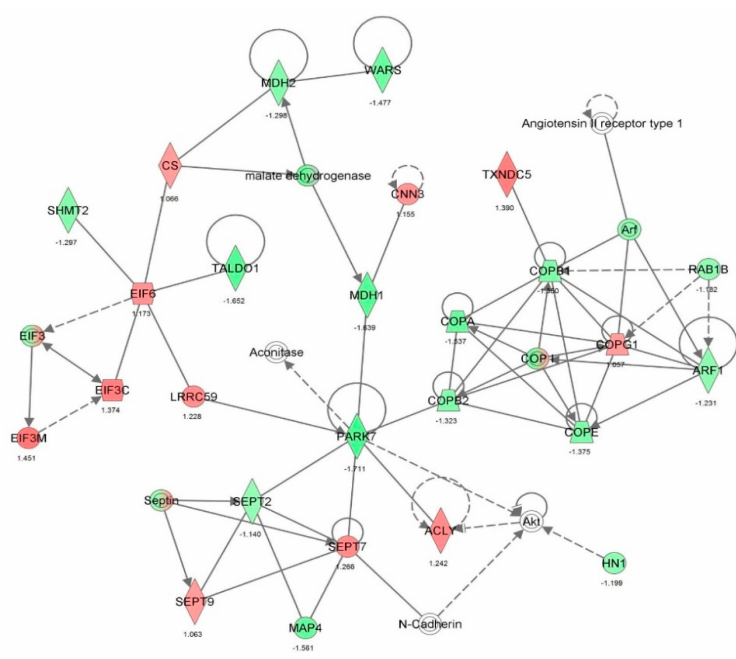
Figure 7. Vancomycin regulated infectious disease, small molecule biochemistry, and reproductive system disease. Red indicates an up-regulation; green indicates a down-regulation. The intensity of green and red colors indicates the degree of down- or up-regulation. Solid arrow indicates direct interaction and dashed arrow indicates indirect